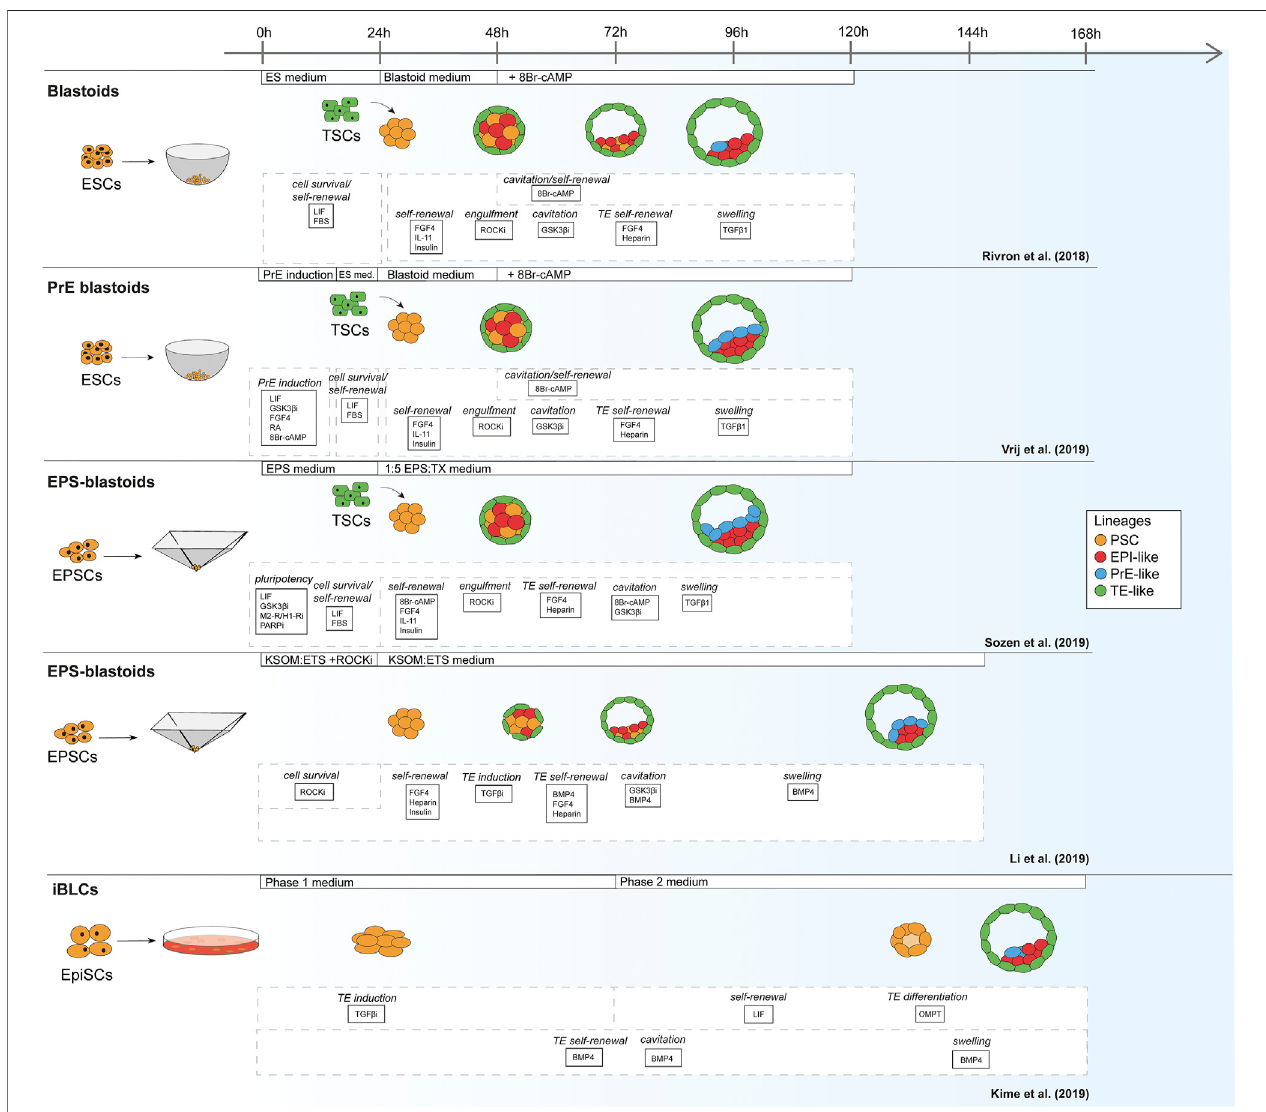
FIGURE 1 | Schematic of mouse blastoid protocols. The names given are taken from the original publications.